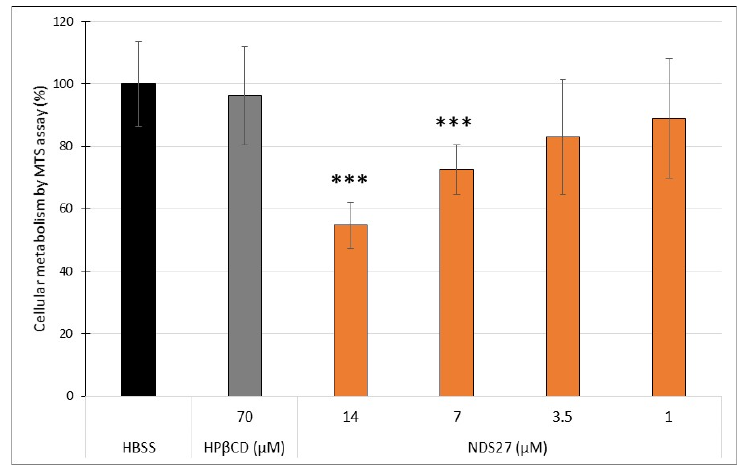
Figure 1. Assessment of cell metabolism of non-loaded (HBSS) and loaded mdMSCs with HP β CD (70 µM) or NDS27 (1, 3.5, 7, 14 µM). The absorbance was read 4 h (T4) after MTS addition (T0) (incubation at 37 °C). Results correspond to the difference of absorbance between T4 and T0. The response of non-loaded cells (HBSS) was set as 100%. Mean ± SD, n = 5 horses. *** p < 0.001 vs. HBSS.